Question: What type of chart is this?
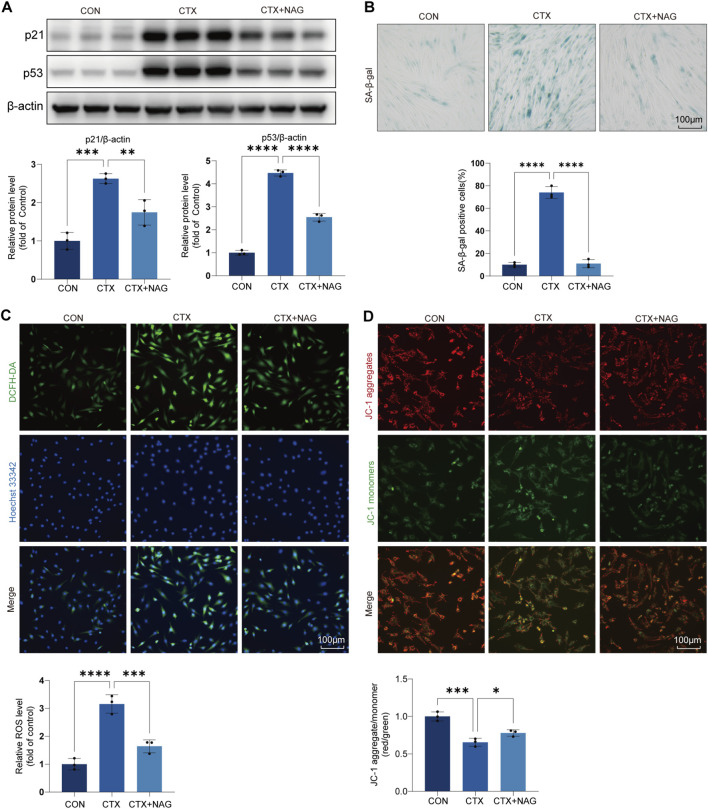
Answer: bar